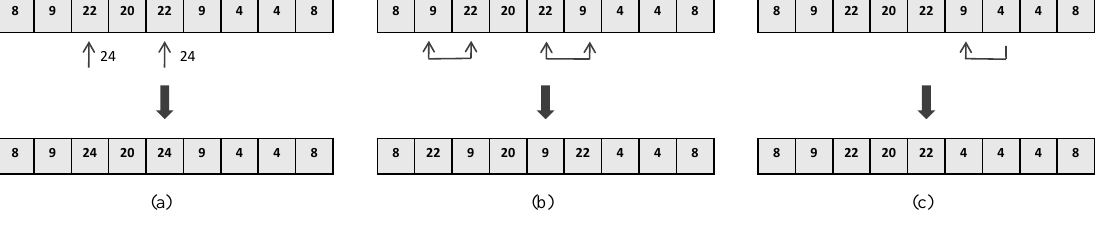
Figure 3. Three mutation operations. ( a ) Replace a selected filter with an unselected filter; ( b ) Exchange two selected filters; ( c ) Replace a channel with another selected channel.